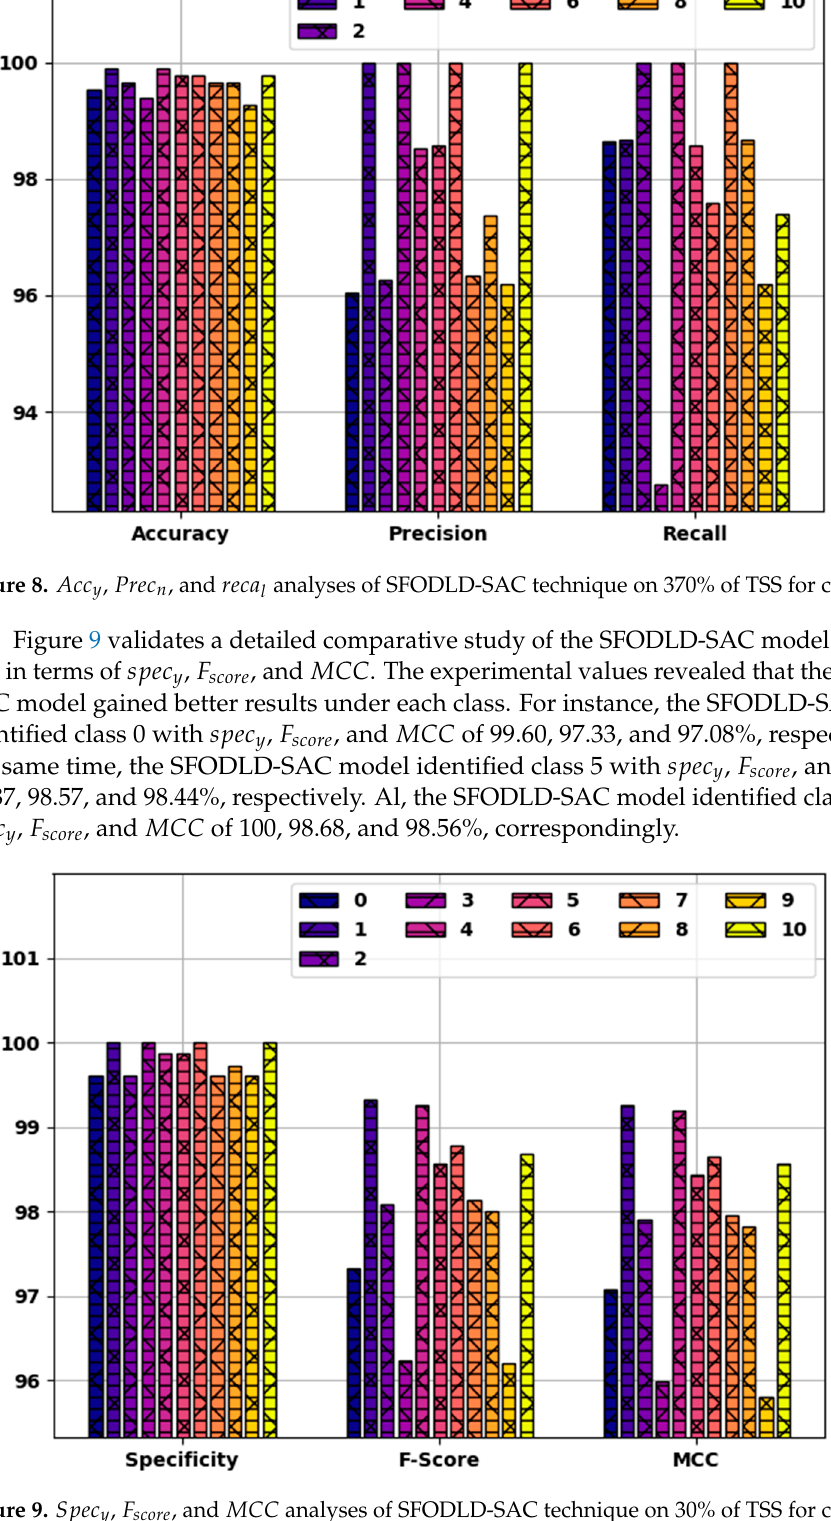
Figure 9. Spec y , F score , and MCC analyses of SFODLD-SAC technique on 30% of TSS for classes Figure 9. 𝑆𝑝𝑒𝑐 (cid:3052) , 𝐹 (cid:3046)(cid:3030)(cid:3042)(cid:3045)(cid:3032) , and 𝑀𝐶𝐶 analyses of SFODLD-SAC technique on 30% of TSS for classes 0–10. Figure 9. 𝑆𝑝𝑒𝑐 (cid:3052) , 𝐹 (cid:3046)(cid:3030)(cid:3042)(cid:3045)(cid:3032) , and 𝑀𝐶𝐶 analyses of SFODLD-SAC technique on 30% of TSS for classes 0–10.